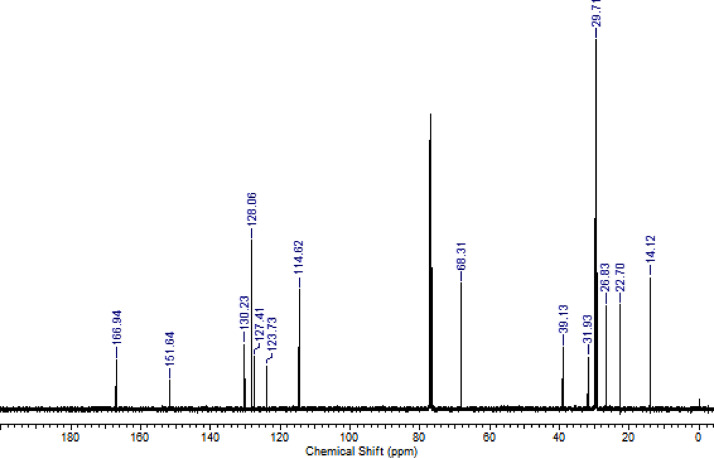
13C NMR (CDCl3, 100 MHz) spectrum of compound 6b.